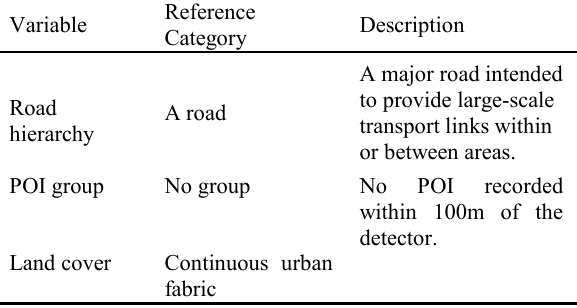
Figure 4 . Histogram of daily average traffic flow.